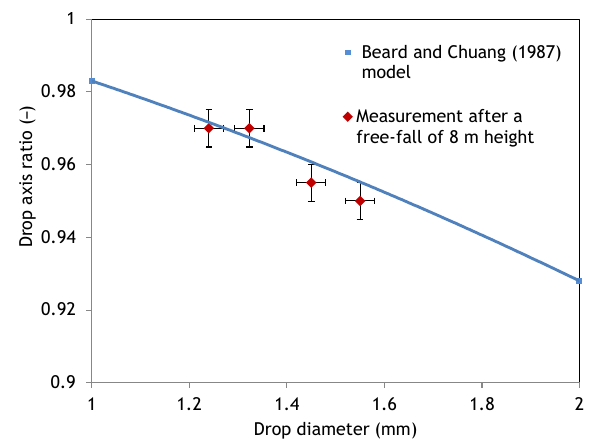
Figure 5. Comparison of velocities measured in BERGAME with the Beard (1976) model.